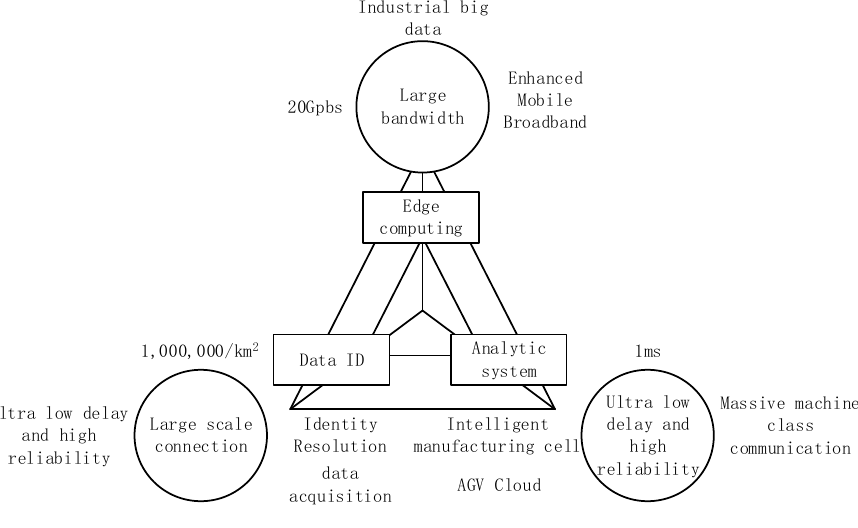
Figure 2. Three key features of 5G